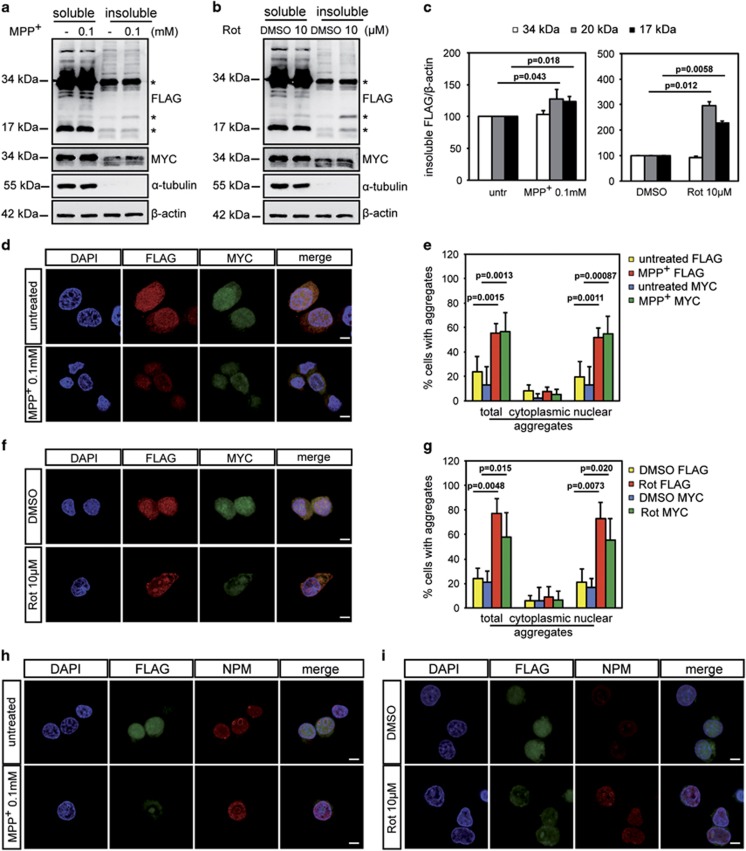
Neurochemical intoxication accumulates insoluble Hb in the nucleolus. Differentiated Hb cells were treated with MPP+ (a, d, h) or rotenone (b, f, i) at the indicated concentrations for 16 h. (a and b) Western blotting analysis of soluble and insoluble fractionation was carried out with anti-FLAG (α-globin) and anti-MYC (β-globin) antibodies. α-Tubulin was used to visualize specifically soluble fraction. β-Actin was used as a loading control. (FLAG n=3, MYC n=2; FLAG n=4, MYC n=2) (c) Densitometric analysis of insoluble FLAG (α-globin) level. Insoluble α-globin level was normalized to β-actin. Untreated cells was used as reference and set to 100%. (n=3, n=3) (d and f) Solubilized double immunofluorescence was performed with anti-FLAG (α-globin) and anti-MYC (β-globin) antibodies. Nuclei were marked by DAPI (4,6-diamidino-2-phenylindole). Scale bar 5 μm. (n=3, n=3) (e and g) Quantification of globin chain aggregates in the cells. An average of 120 randomly chosen cells were counted for quantification of each condition. Values are expresses as a percentage relative to the total. (h and i) Solubilized double immunofluorescence was performed with anti-FLAG (α-globin) and anti-NPM antibodies. Nuclei were marked by DAPI. Scale bar 5 μm. (n=2, n=2) Values are mean±S.D. Data were evaluated statistically by Student's t-test. Resulting P-values are indicated